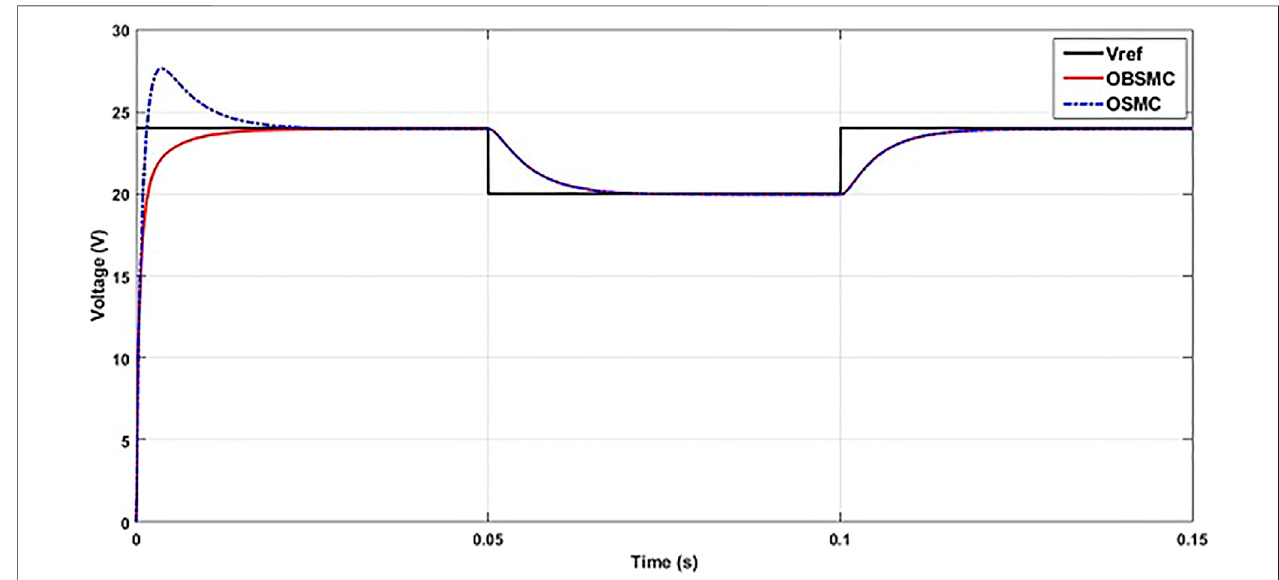
FIGURE 6 | Output voltage of the converter for reference voltage